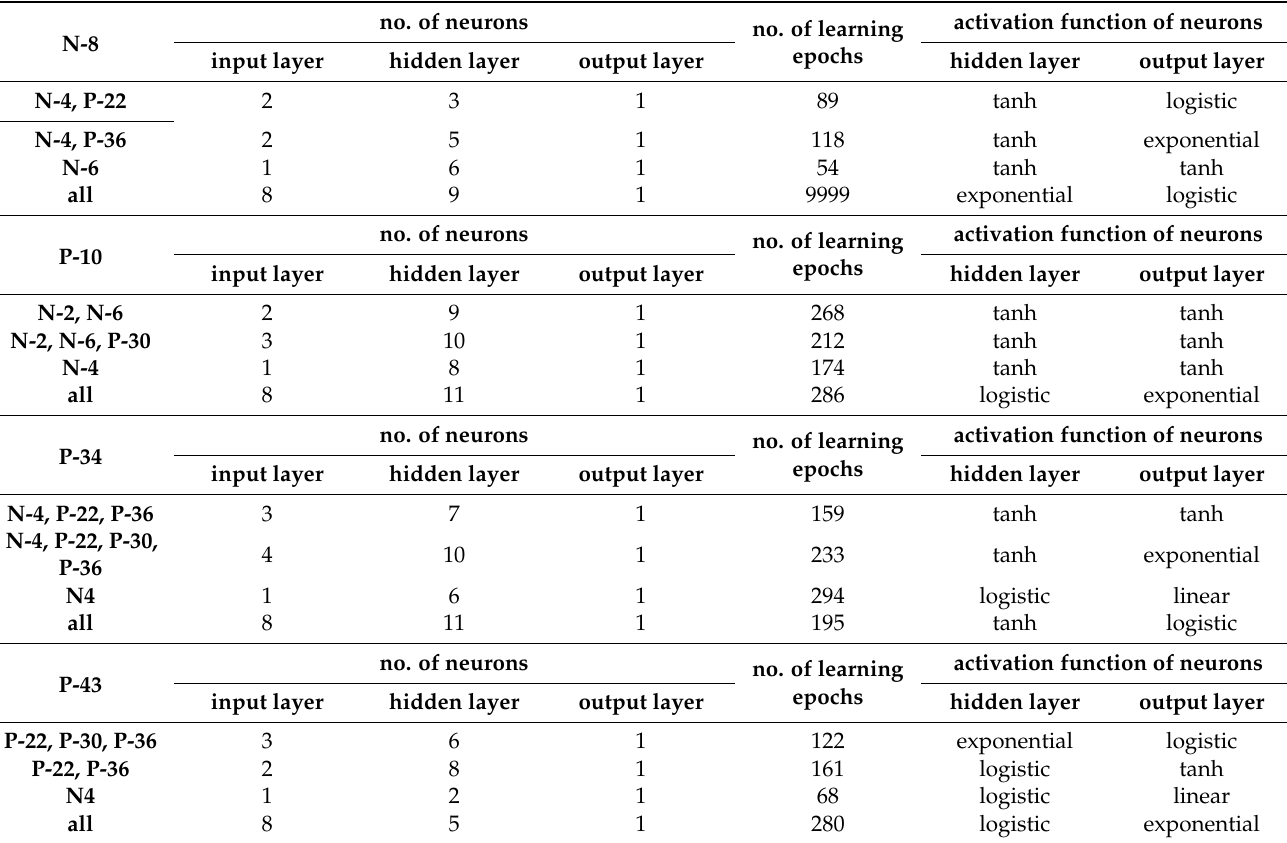
Table 1. Artificial neural network (ANN) model